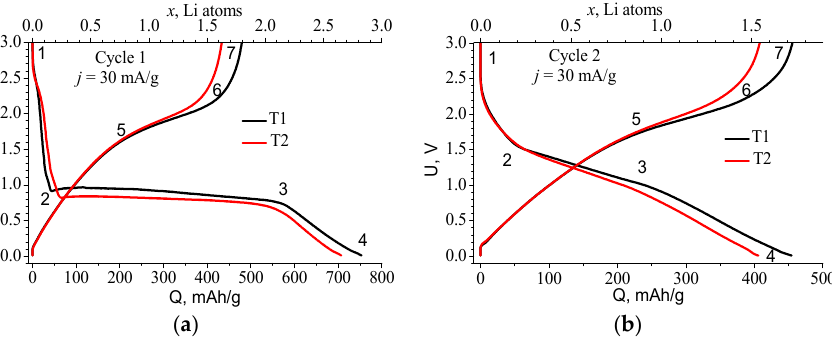
Figure 1. Charge–discharge curves of the T1 and T2 anodes: ( a ) first and ( b ) second cycle, recorded at j = 30 mA/g.